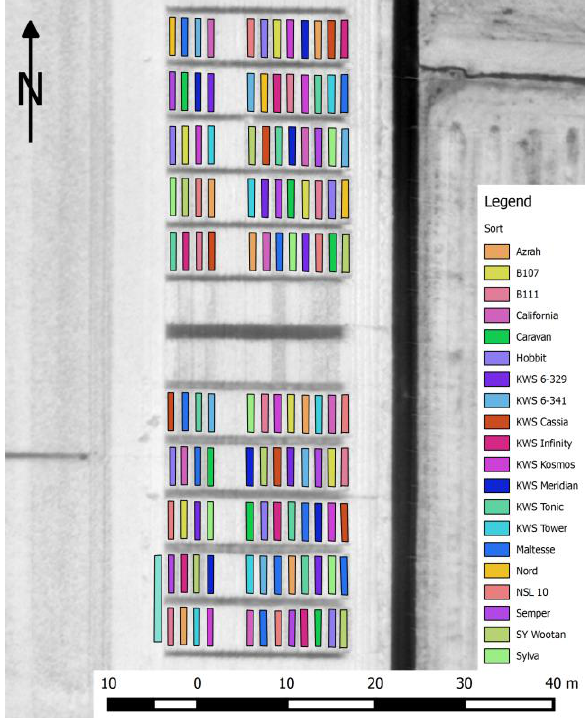
Figure 7. Barley test field with plots of 20 different species and two different treatments: Extenso (bottom) and ÖLN